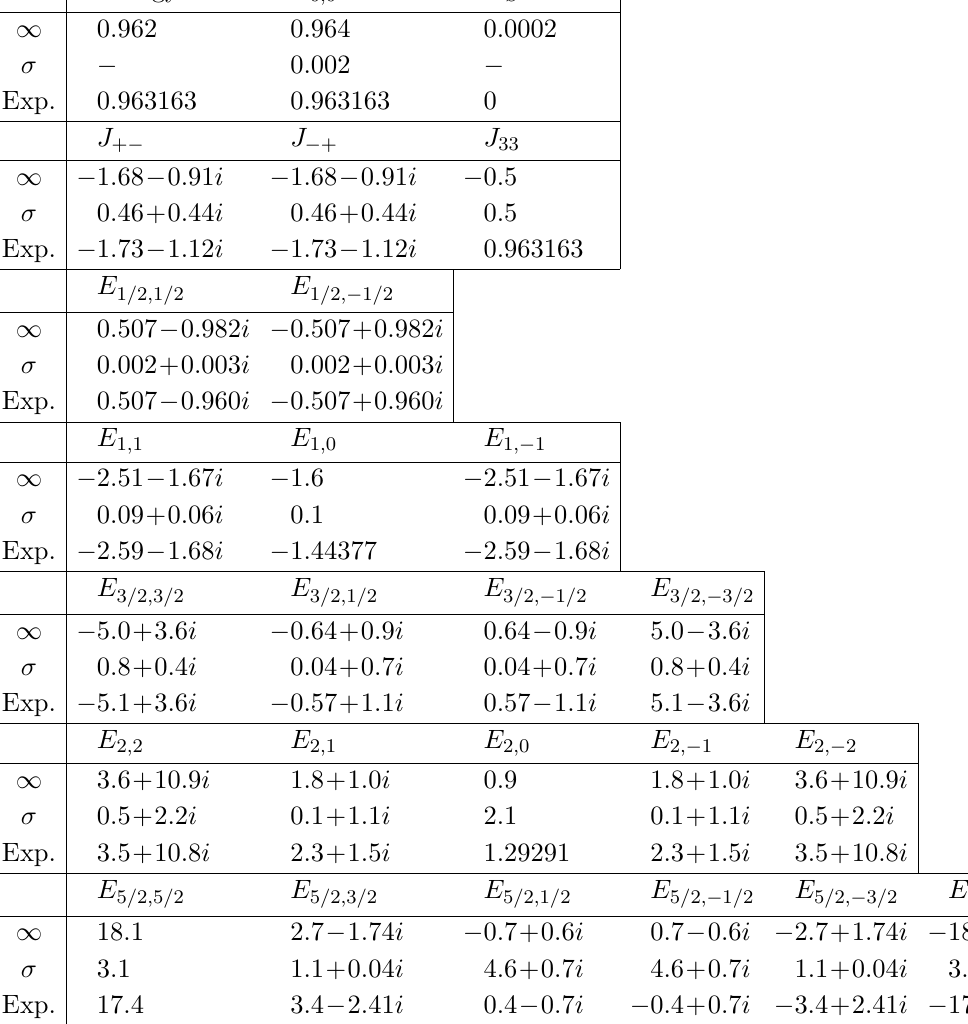
Table 31 . Extrapolations of observables of a solution describing two SL(2, C ) 0-branes with , θ = − 2 π , ρ 0 . 49 and ρ = 1 /ρ 2 . 05 in the k = 5 model with J = 1 boundary conditions. θ 1 = 2 π 2 1 ≈ 2 1 ≈ k k Extrapolations are done only using even level data due to odd level